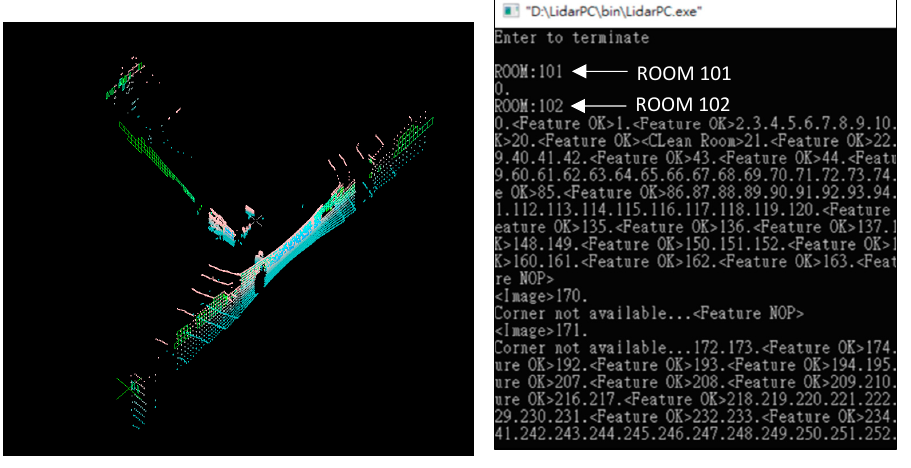
Figure 11. LiDAR localization software.